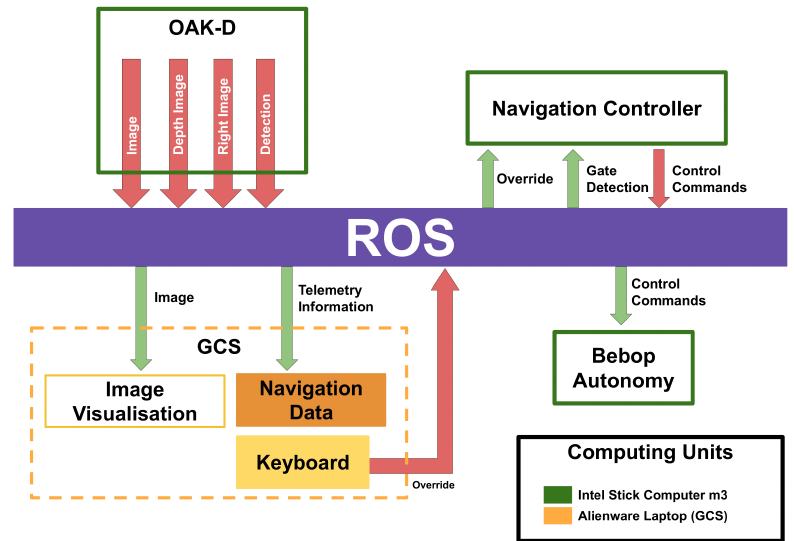
Figure 9. Communication system based on the robotic operating system. Nodes running on the Intel Stick (full onboard processing) are marked in green. Nodes running on the ground control station (GCS) are marked in orange. The GCS is only used for visualisation of imagery and telemetry transmitted by the system running onboard the drone.